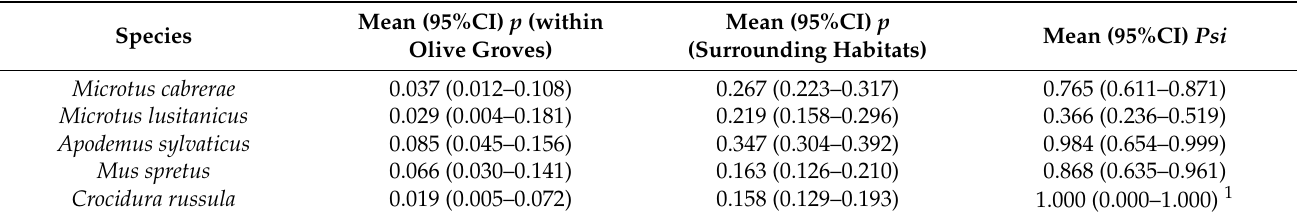
Table 2. Detectability ( p ) and occupancy ( Psi ) estimates of small mammals in NE Portugal according to the models including the effects of transect location, i.e., within focal olive groves versus in surrounding semi-natural